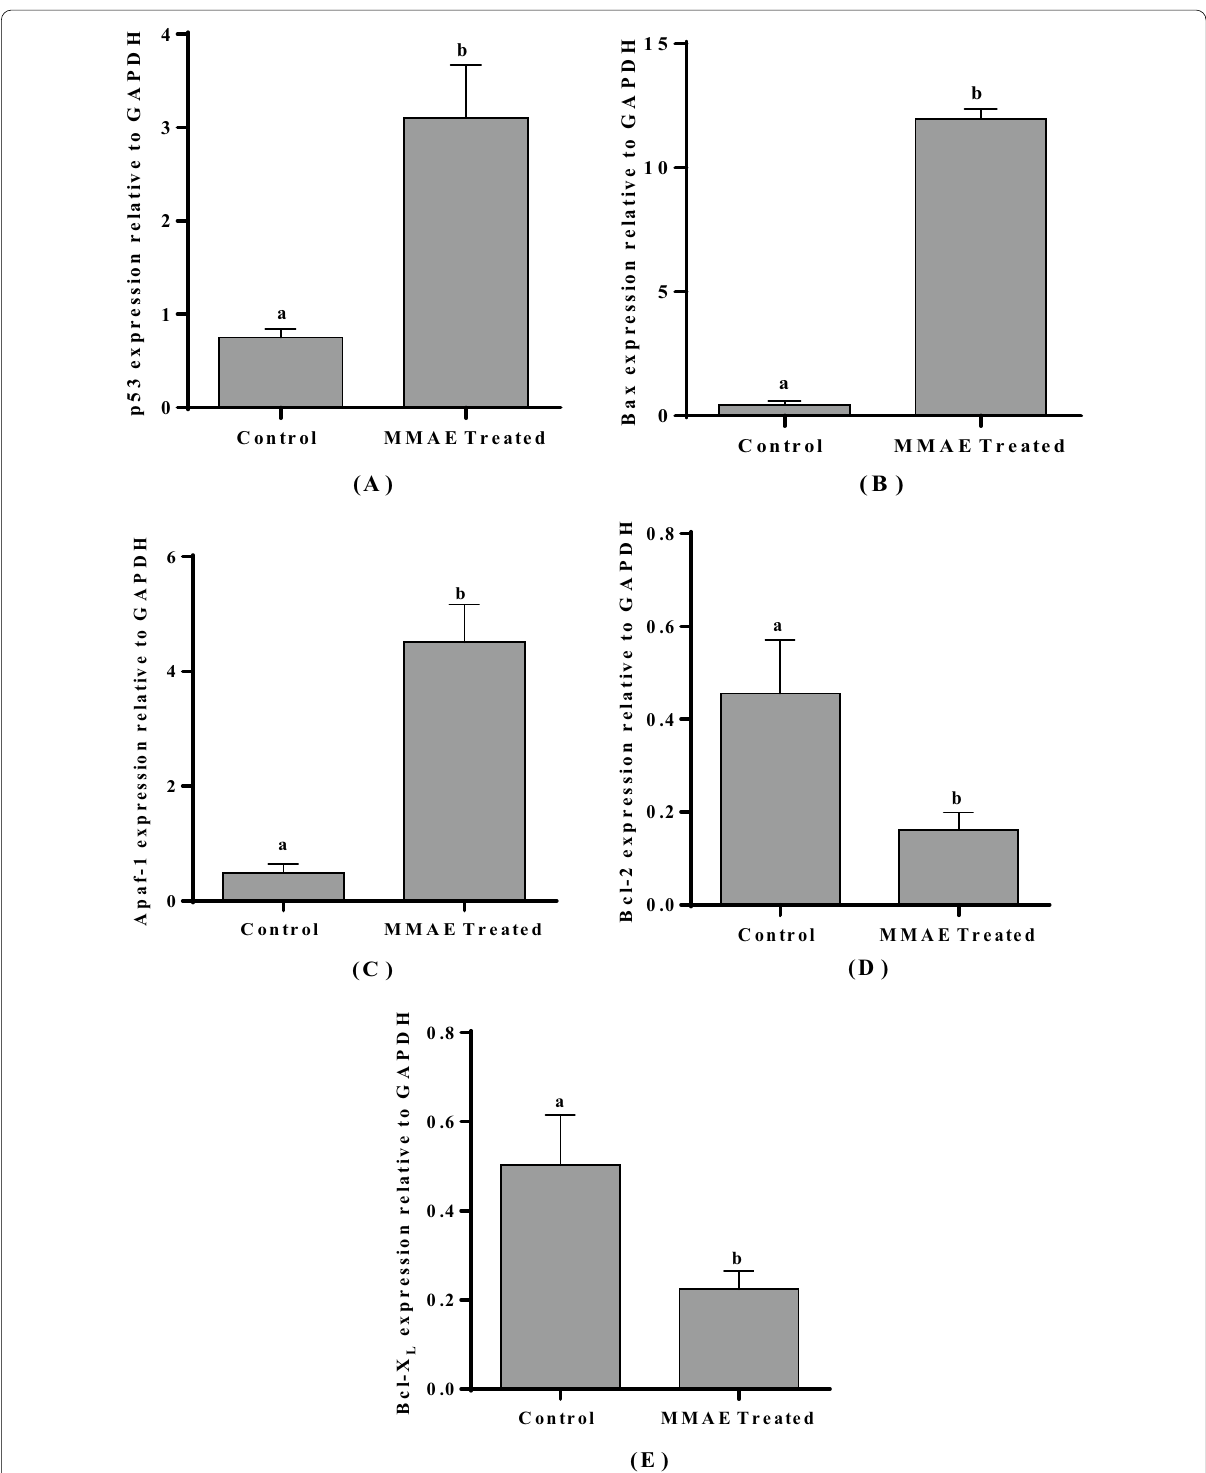
Fig. 4 Effects of aqueous extract of M. macrophylla on mRNA expression levels of A p53; B Bax; C Apaf1; D Bcl-2; E Bcl- X L in Dalton’s Lymphoma Ascites (DLA) bearing mice. Control: DLA bearing mice without treatment. MMAE treated: DLA bearing mice treated with 100 mg/kg of aqueous extract of M. macrophylla . Different letters indicate significant variation at p <